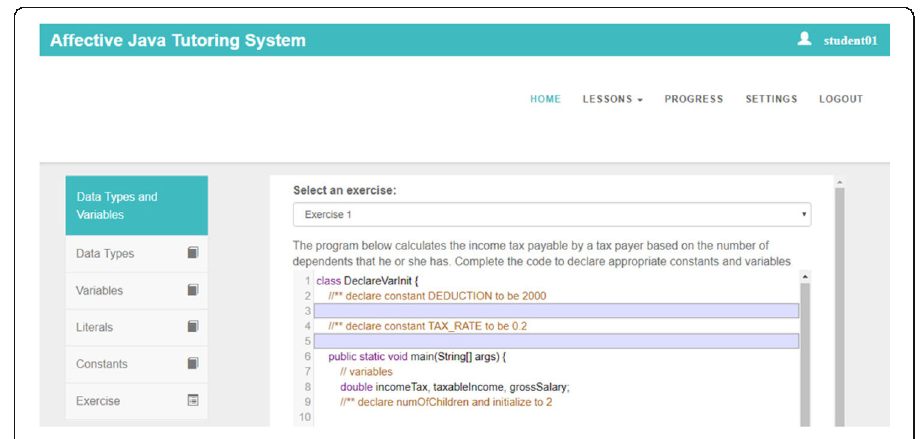
Fig. 4 Fill in the gap programming